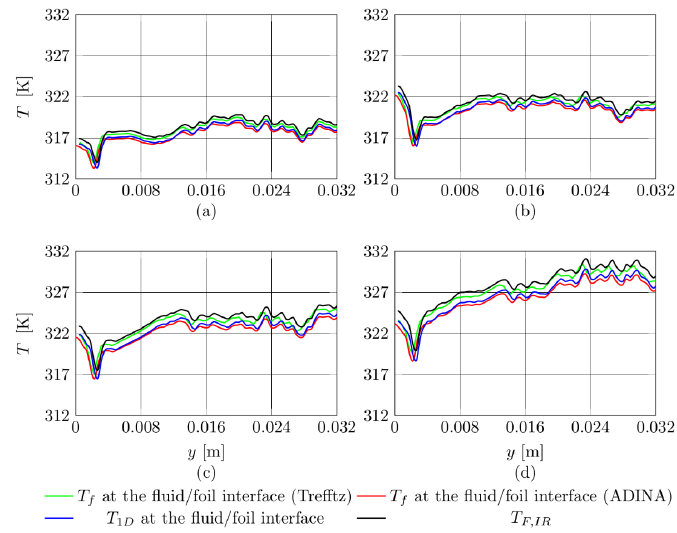
Figure 8. Temperature vs. the distance from the minichannel inlet at the fluid/foil interface obtained from 2D computations using the Trefftz functions (green line), ADINA software (red line), according to the 1D approach (blue line) and T F,IR ( y )—the data from experimental measurements on the outer foil surface due to infrared thermography (black line); the test section with three minichannels; experimental parameters listed in Table 2, heat flux values: ( a ) q’’ = 68 kW/m 2 ; ( b ) q’’ = 75.7 kW/m 2 ; ( c ) q’’ = 100.2 kW/m 2 ; ( d ) q’’ = 123.5 kW/m 2 .